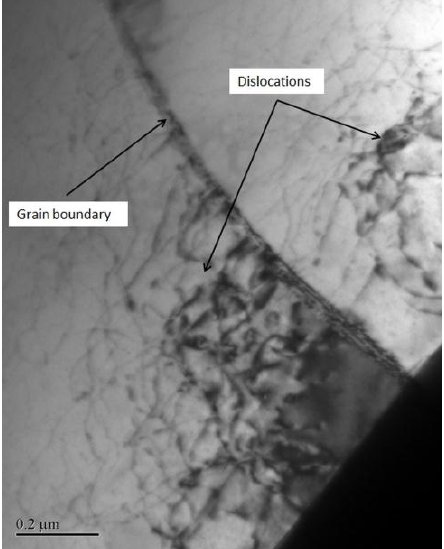
Figure 10. TEM image of A356 alloy after the modification process by TiCN nanoparticles with a high concentration of dislocations near a grain boundary of the